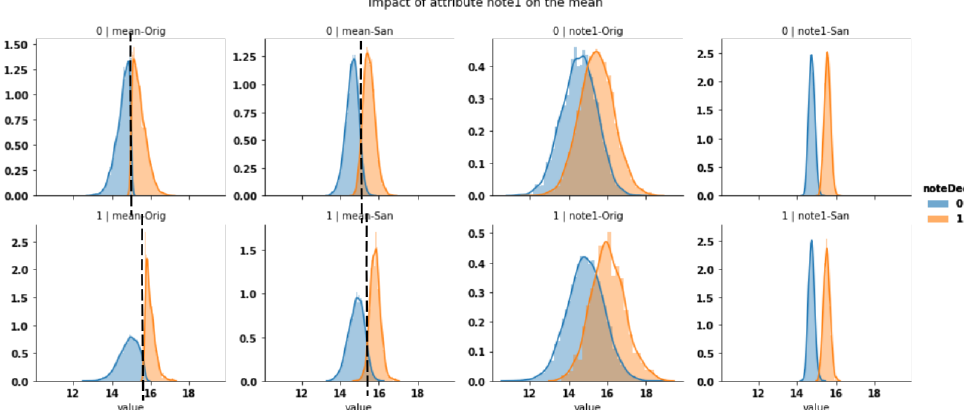
Figure 15. Decision boundary based on the mean of all attributes note x on original (left-most) and sanitized (second left) for the group gender = 0 (top) and gender = 1 (bottom). The sanitization has modified the decision boundary of both groups, such that they are almost identical. The modification is only on attribute note 1 , which means that the decision attribute is not affected. Orig denotes the original distribution while San refers to the sanitized one. The sanitized distribution of note 1 thus matches the decision